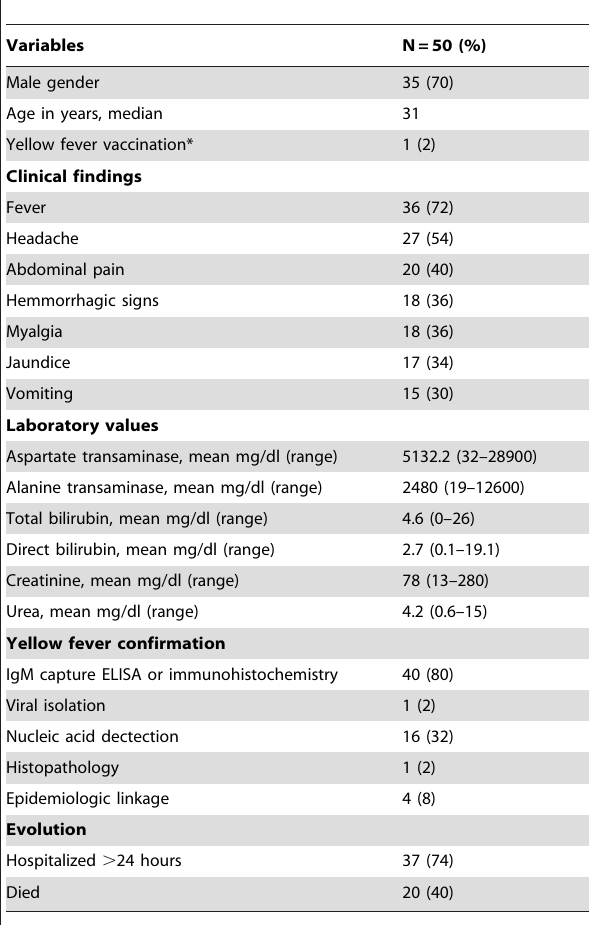
Table 1. Patient characteristics, clinical findings and laboratory values for laboratory-confirmed yellow fever, Brazil,